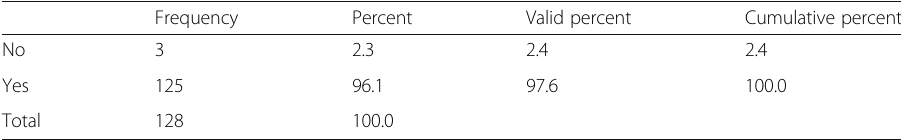
Table 13 Sponsorship continuity